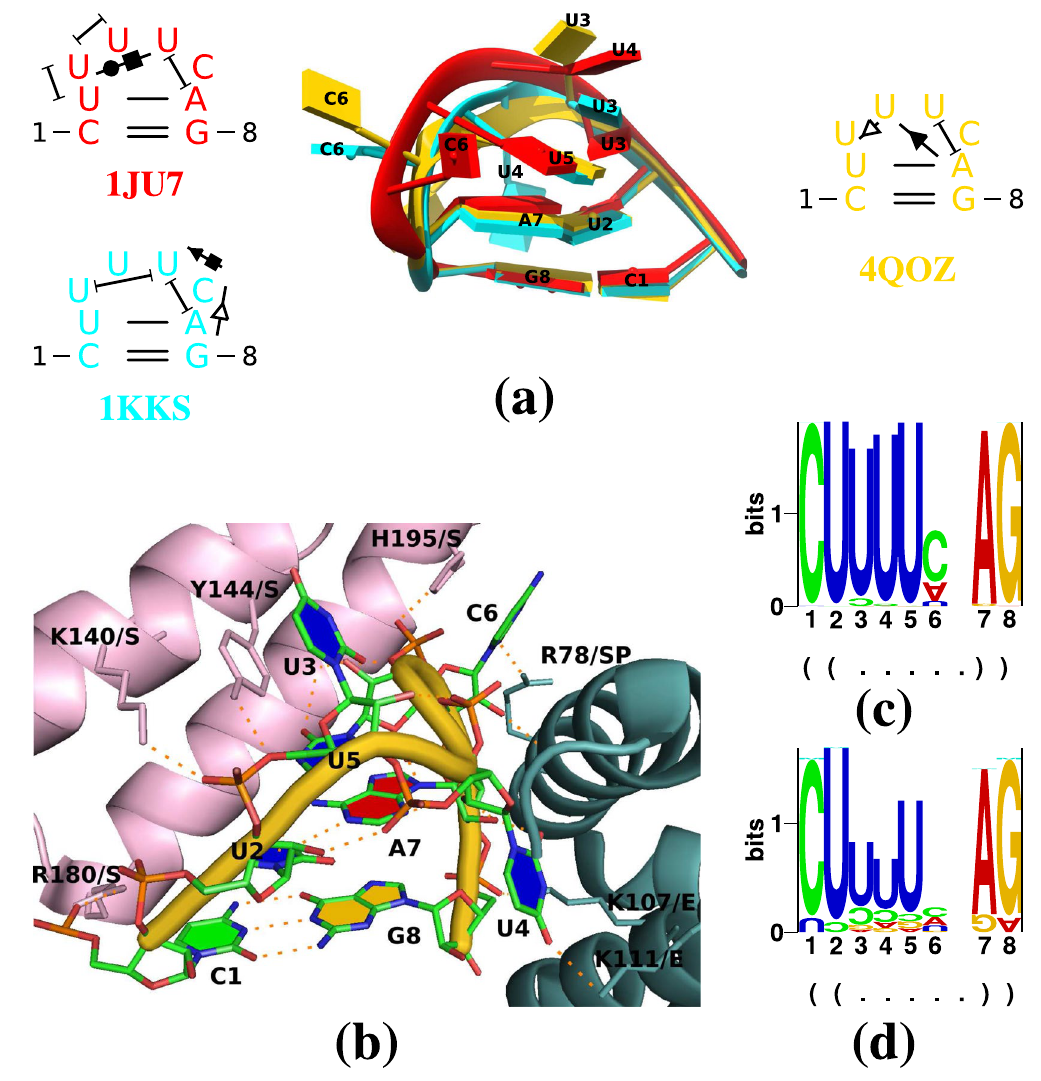
Figure 7. Histone mRNA stem-loop. This hairpin loop including the closing base pair is identical in sequence to PSTVd’s HP (Fig. 5a). ( a ) Comparison of hairpin loops of PDB entries 1JU7 (red), 1KKS (cyan), and 4QOZ (gold); model 5 of 1JU7 and model 8 of 1KKS are shown, which are annotated as best structures in their respective PDB files. Views from different angles are shown in Supplementary Fig. S4. ( b ) Hairpin loop (cartoon in gold) from 4QOZ, bound by Exo (cartoon in lightpink) and SLBP (cartoon in darkgreen); a few amino acid side chains, which interact with RNA backbone and bases, are labelled. ( c ) Logo of 11,099 histone mRNA loops from Rfam-11 79 (ID: Histone3); three sequences have an additional nucleotide after position 6. ( d ) Logo of 36 non-redundant histone mRNA loops from